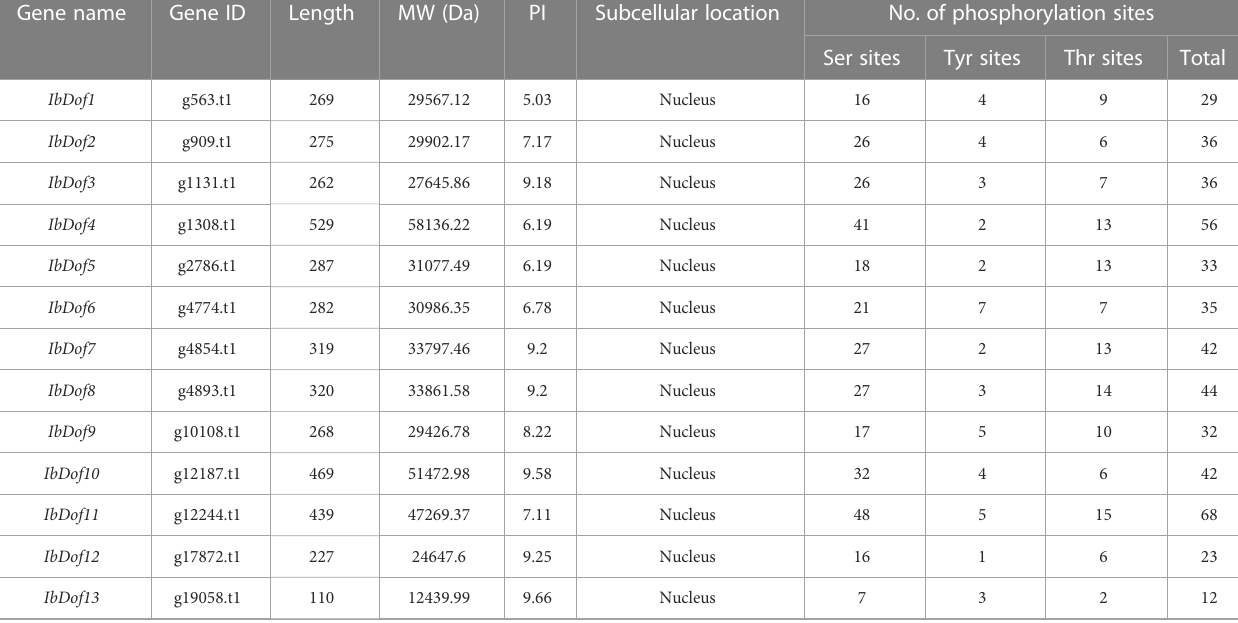
TABLE 1 Characteristics of IbDof genes in Ipomoea batatas